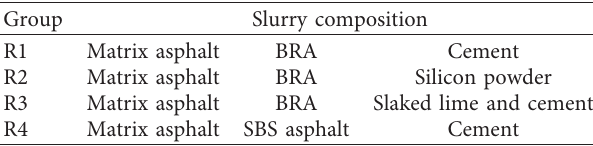
Table 6: Slurry composition of test groups.